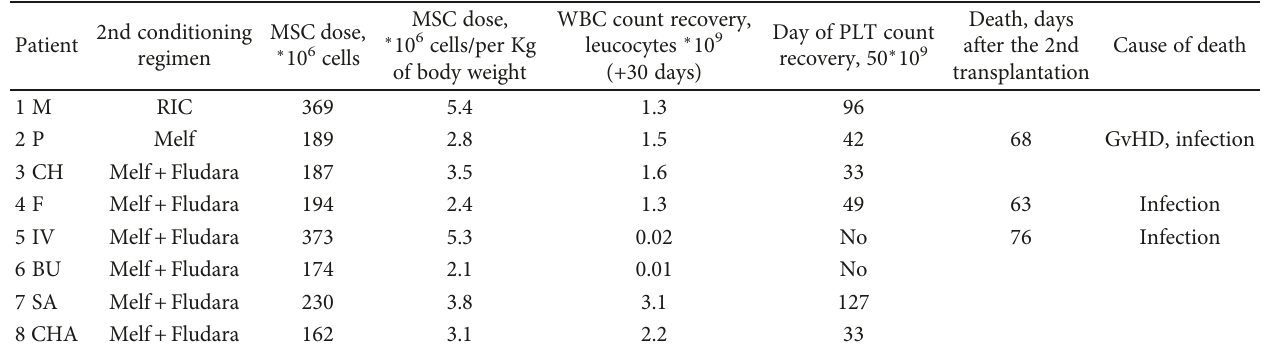
Table 2: Characteristics of the 2nd